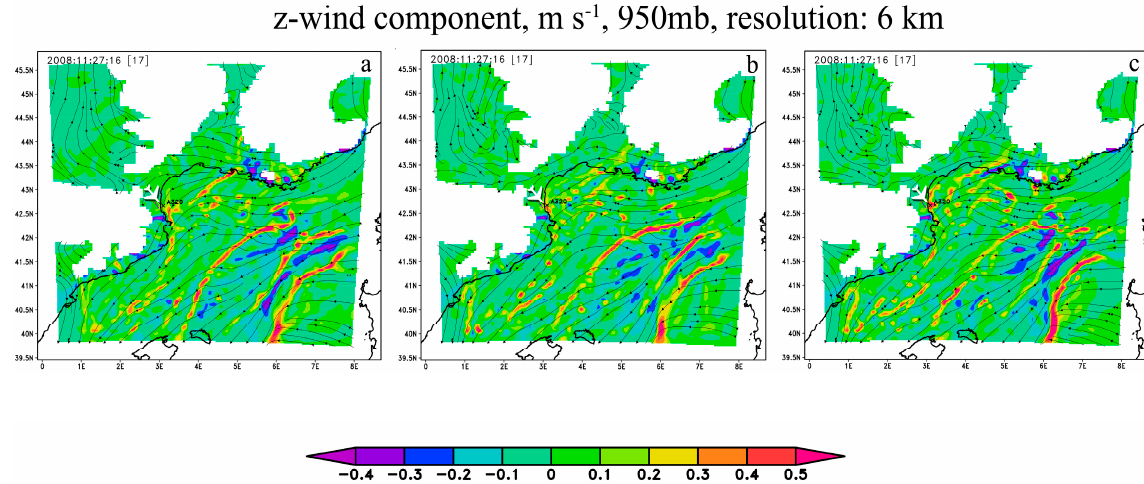
Figure 8. The ( a , b , c ) are same as in Figure 7 but the simulations were done with a 6 km model